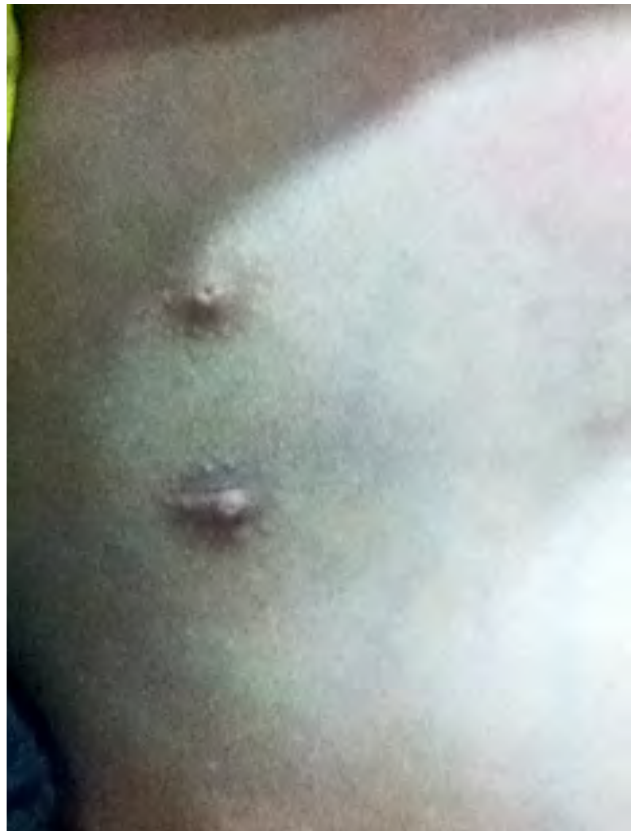
Figure 1 : supernumerary nipple on the right side.